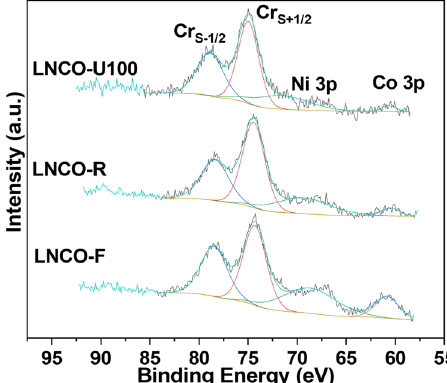
Fig. 3 Ni 3p, Co 3p, and Cr 3s XPS spectra of LNCO samples. Cr S + 1/2 and Cr S-1/2 denote intra-atomic multiplet splitting of Cr 3s with the remaining 3s electron coupled parallel and antiparallel to the 3d electrons,